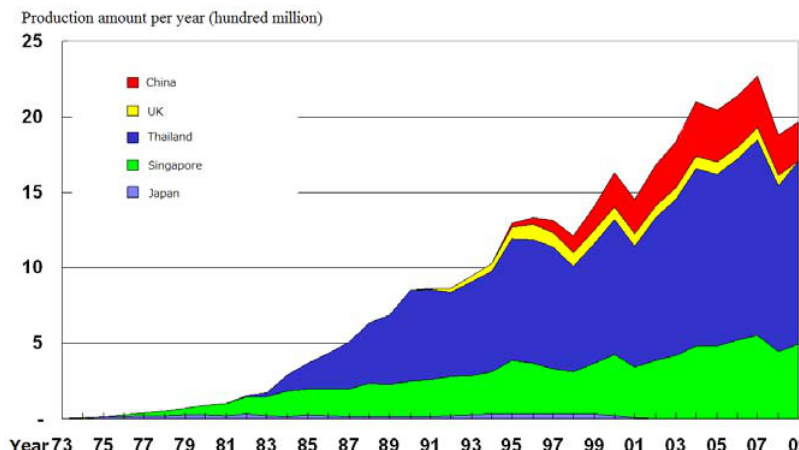
Figure 1. Minebea bearing production volumes Source: Minebea internal